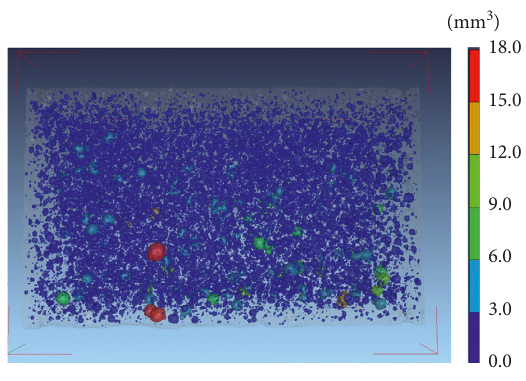
Figure 10: 3D defects distribution of a plain UHPC specimen (40mm × 40mm × 160mm) before the freezing-thawing